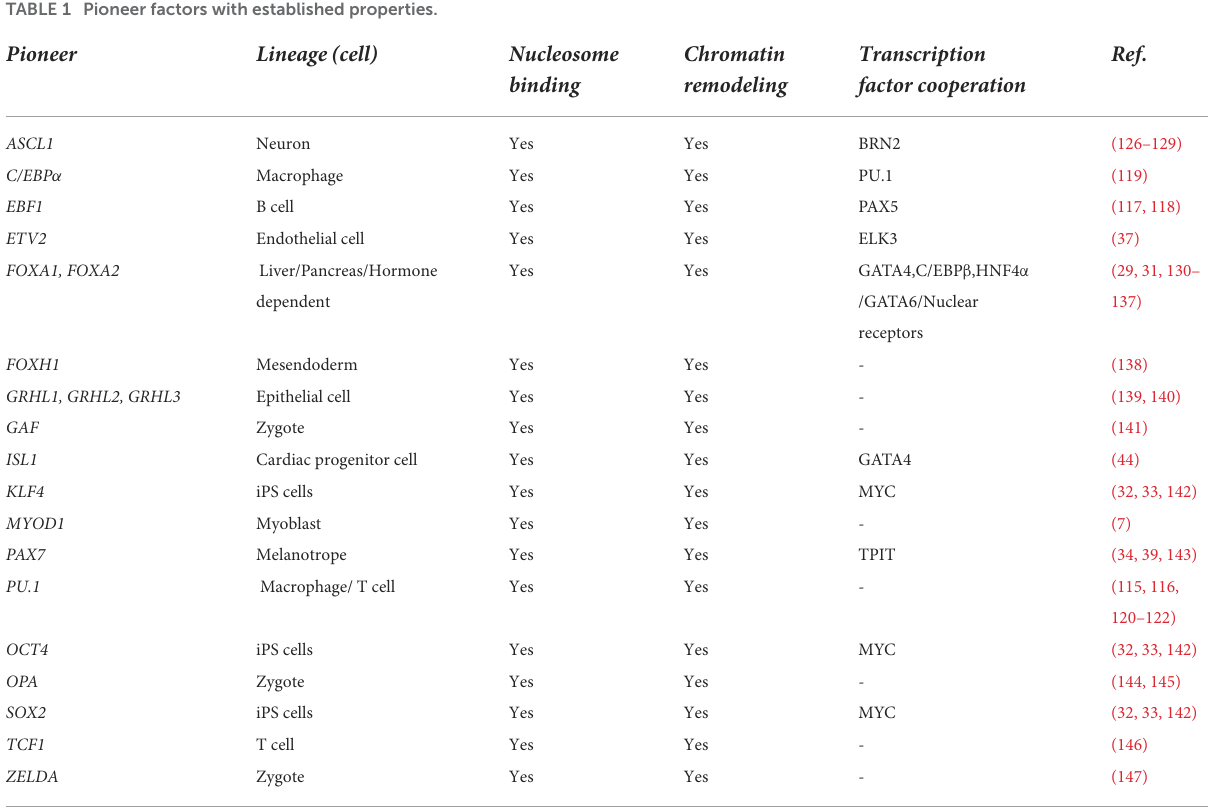
TABLE 1 Pioneer factors with established